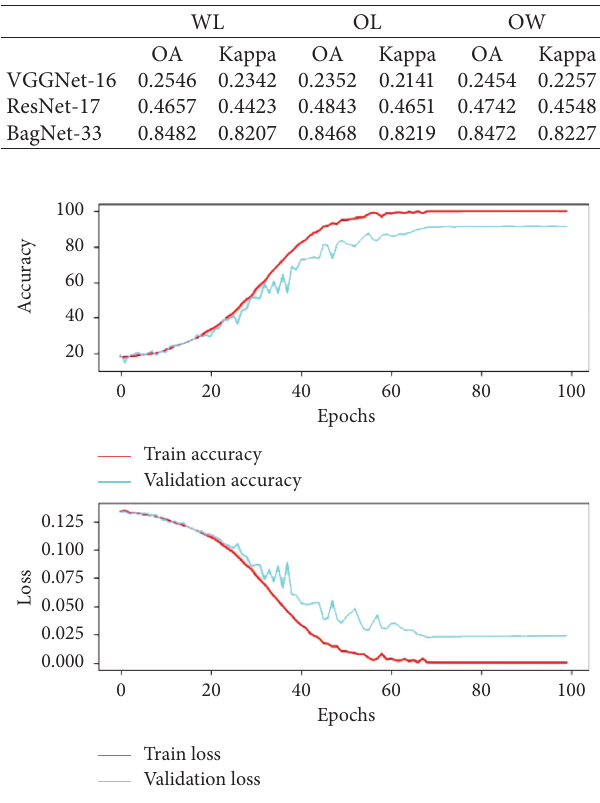
Table 6: Accuracy comparison of different models.